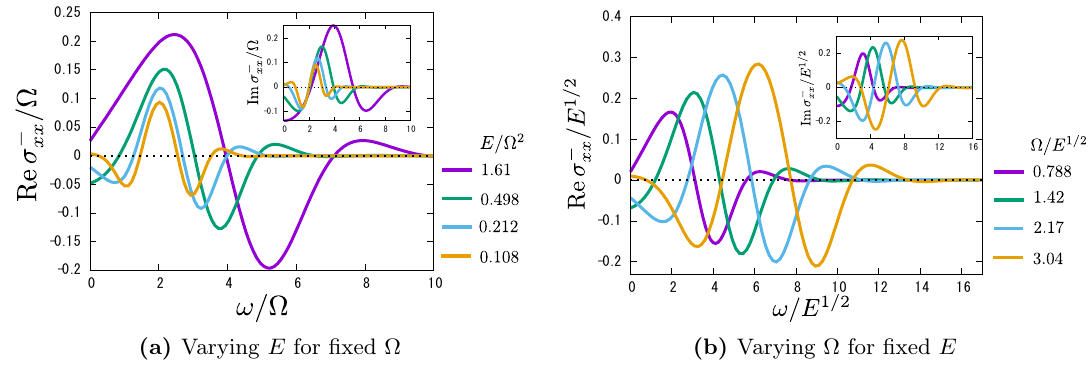
against probe AC electric (cid:12)eld. xx